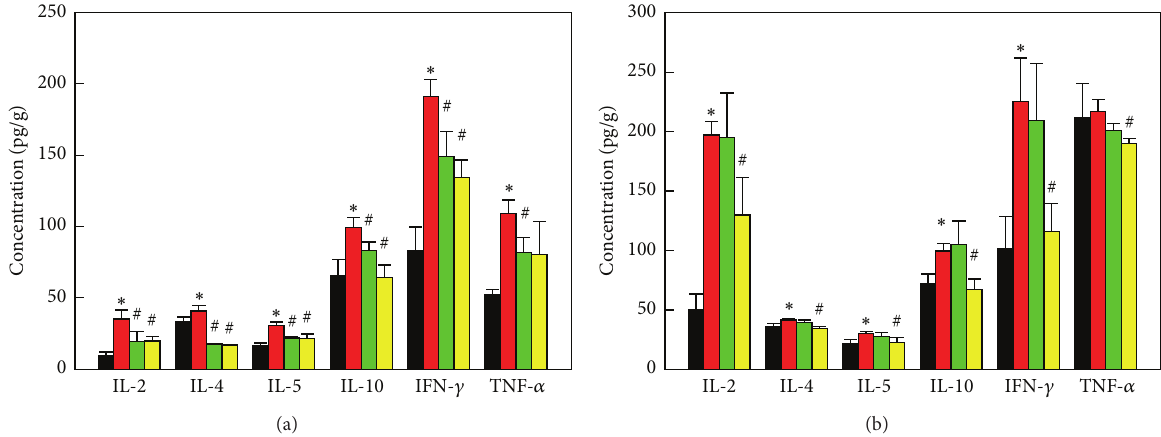
Figure 3: Effects of F3 or F3.olig2 cell transplantation on the myelin oligodendrocyte glycoprotein- (MOG-) induced increase in the cytokines in the spinal cords (a) and lymph nodes (b). Black: normal, red: MOG alone, green: MOG+F3 cells, yellow: MOG+F3.olig2 cells, IL: interleukin, IFN- 𝛾 : interferon- 𝛾 , and TNF- 𝛼 : tumor necrosis factor- 𝛼 . ∗ Significantly different from normal control ( 𝑃 < 0.05 ). # Significantly different from MOG alone ( 𝑃 < 0.05